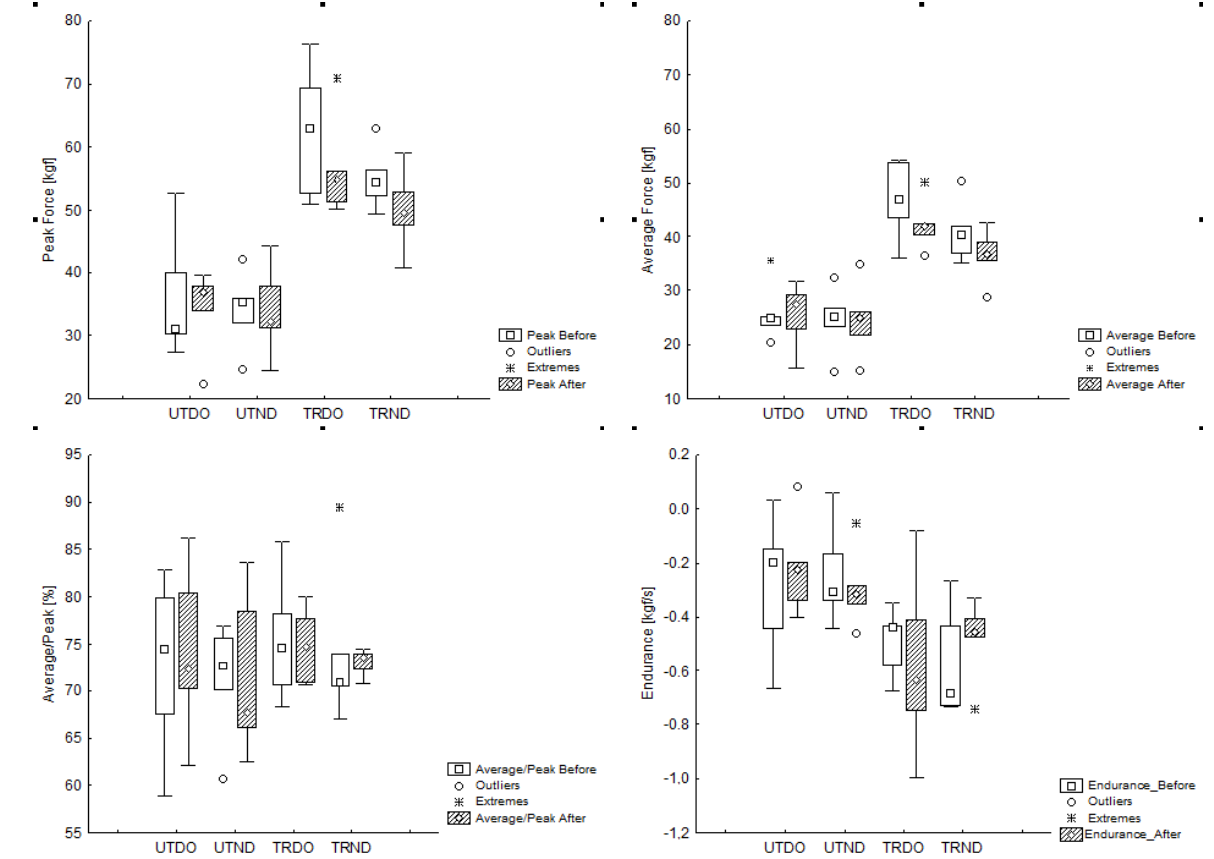
Figure 1. Analysis of the four dynamometry variables evaluated among the four subgroups before and after induced fatigue in upper limbs. UT: untrained; TR: trained; DO: dominant; ND: non-dominant; Significant intragroup differences: Peak force TRDO ( p = .027709); Raw average TRDO ( p = .046400) and TRND ( p = .027709). Significant intragroup differences before fatigue: Peak force TRDO / UTDO ( p = .003017) and TRND / UTND ( p = .000848); Raw average TRDO / UTDO ( p = .005031) and TRND / UTND ( p = .005031); Endurance TRND / UTND ( p = .017236). Significant intragroup differences after fatigue: Peak force TRDO / UTDO ( p = .009824) and TRND / UTND ( p = .009824); Raw average TRDO / UTDO ( p = .014172) and TRND / UTND ( p =